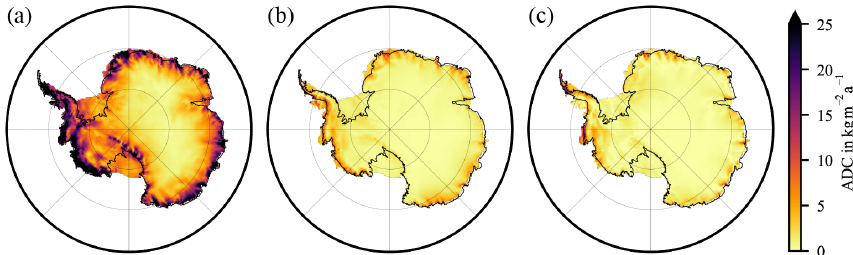
Figure 3. Three uncertainty assessments for the area density change (ADC) trend induced by cumulated surface mass balance anomalies (cSMBA). (a) The rms of cSMBA trend differences between RACMO2.3p2 and MAR for all 7-year intervals (Sect.3.3), (b) the formal uncertainty from least-squares estimation for March 2003–October 2009, and (c) the 10% uncertainty assumption.